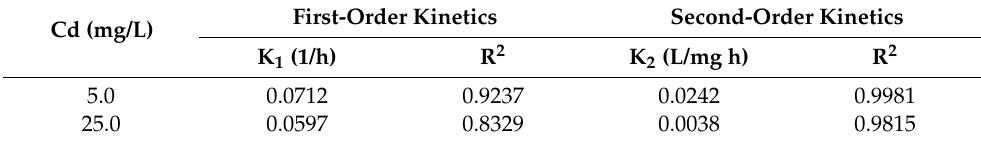
Table 1. First- and second-order kinetic parameters obtained for Cd removal by Oscillatoria sp.